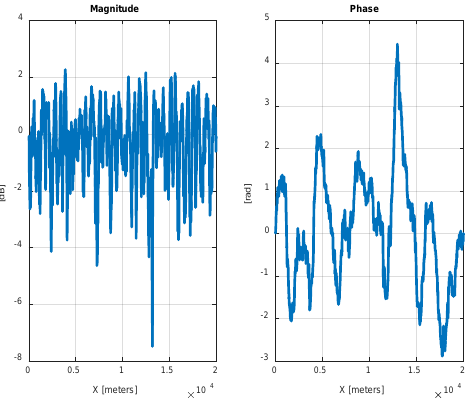
Figure 4. Kolmogorov Phase Screen Interaction on incident E- field, the received E-Field at 170 km The SM average error comparison to the analytic solution declines by twelve orders of magnitude while the FDM average error declines by three orders of magnitude when comparing the phase screen error response and the Gaussian lens error response. The phase screen causes issues for the SM algorithm at the left and right hand boundaries. The global trigonometric interpolants of the SM algorithm are not as effective in computing the electric field for non-uniform input functions observed with phase screens due to an absence of smoothness and periodicity. This is also reflected in the variance and standard deviation of the error as shown in Figures 5 and 6 for a distance of 70,000 meters.